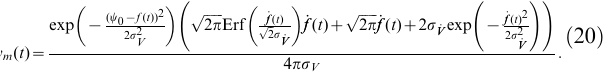
nomenclature overview can be found in Table 1. The voltage correlation function C ( t ) is characterized by its peak value C (0) ~ s 2 and the finite correlation time constant t s ~